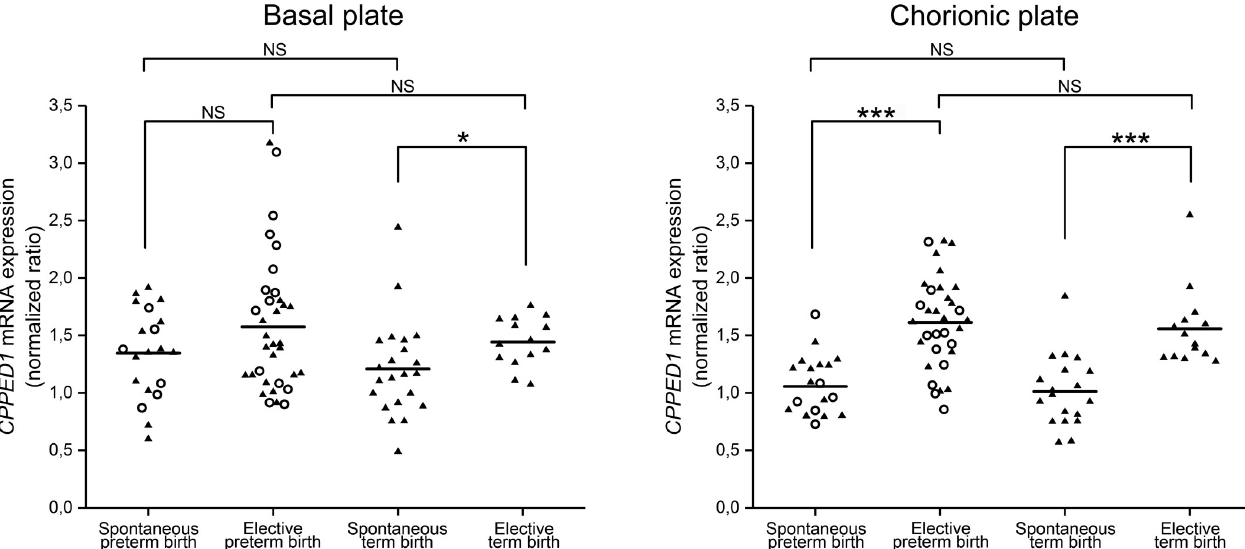
Fig 1. CPPED1 mRNA levels in preterm and term placentas. Normalized expression levels of CPPED1 in human preterm and term placentas to compare spontaneous and elective deliveries. CPPED1 expression was decreased during spontaneous preterm birth in the chorionic plate (right panel) but not in the basal plate (left panel). At spontaneous term birth, CPPED1 mRNA levels decreased in both basal and chorionic plates. There was no difference in CPPED1 expression in placentas from preterm and term spontaneous and elective deliveries. Differences were analyzed with nonparametric Kruskall–Wallis test. Horizontal line denotes the median of each group. Statistically significant changes are indicated by one ( p < 0.05) and three ( p < 0.001) asterisks; NS, not significant. Preeclampsia and intra-amniotic inflammation cases are indicated by an open circle.